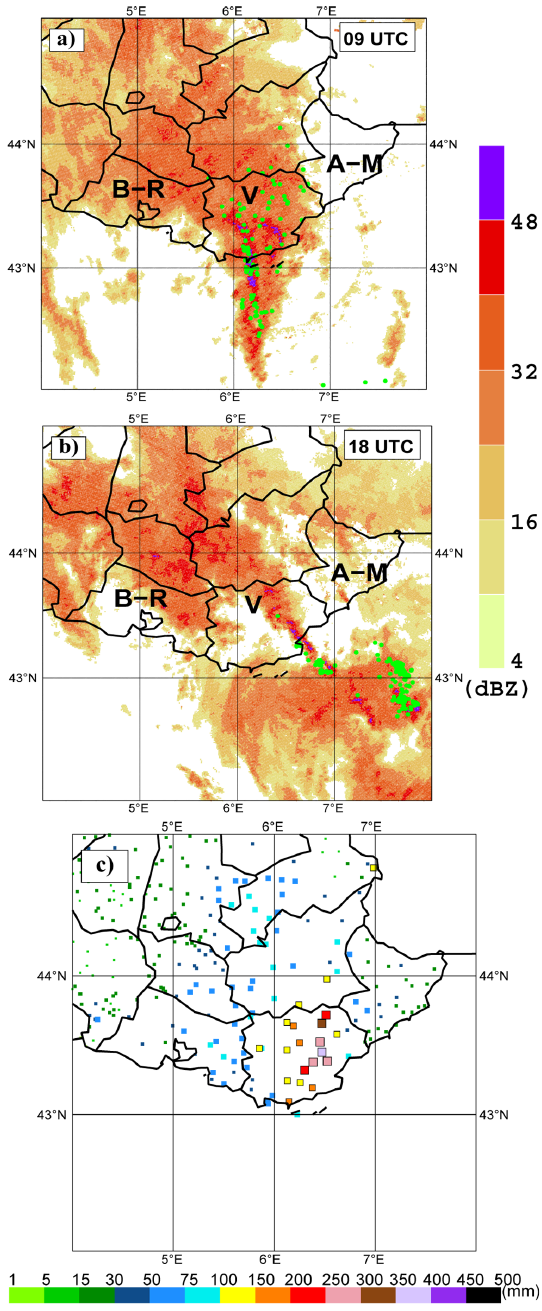
Fig. 2. Var case radar reflectivities composite from the observations on 15 June 2010 at (a) 09:00UTC, and (d) 18:00UTC, respectively. The green squares show lightning strikes observed during 3h from the radar time. The thin lines delineate the departments (administra- tive areas of France); the Bouches du Rh ˆ ones, the Var and the Alpes- Maritime departments are labelled B-R, V, and A-M, respectively. (c) stands for rainfall observations from 06:00UTC, 15 June 2010 to 06:00UTC, 16 June